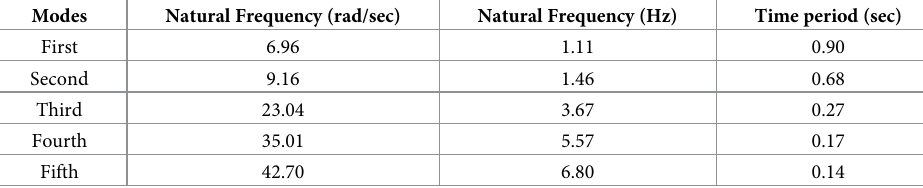
Table 2. Modal properties of steel frame equipped with TLCD.